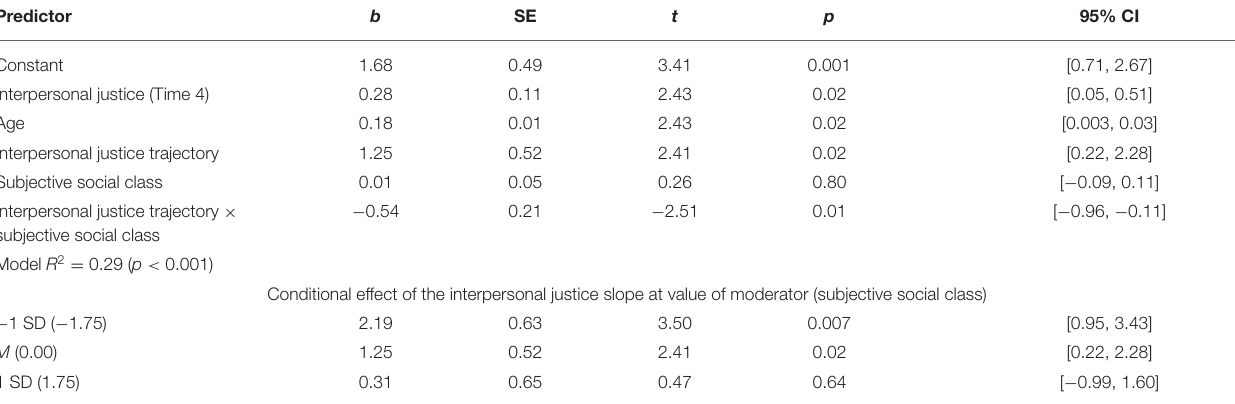
Interpersonal justice trajectory × subjective social class Model R 2 = 0.29 ( p < 0.001)